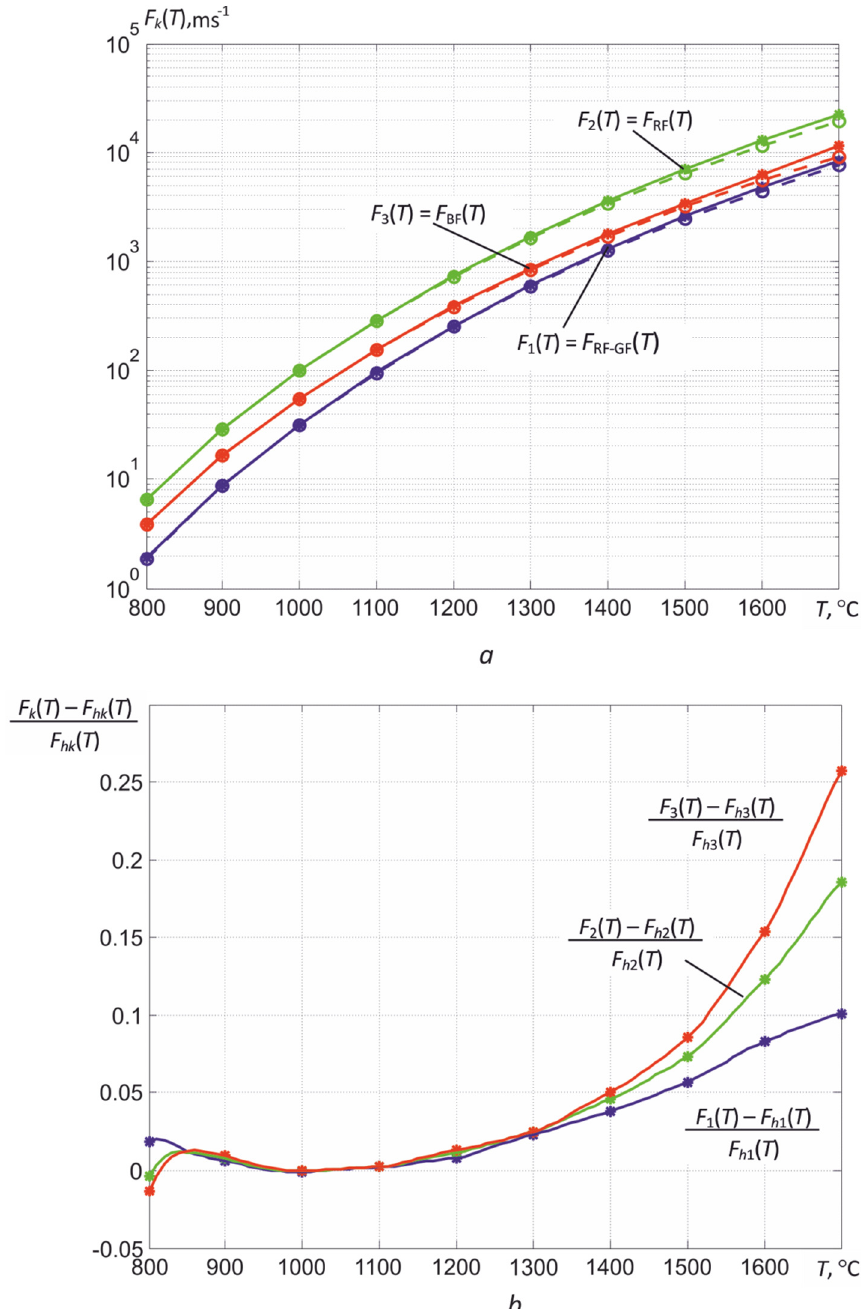
Figure 18. Experimental F k ( T ) (solid lines) and corrected calculated F hk ( T ) (dashed lines) calibration curves for a three-spectral thermograph sample based on the MT9V034C12STC matrix ( a ), as well as relative deviations of the experimental dependences from the calculated ones ( b ).